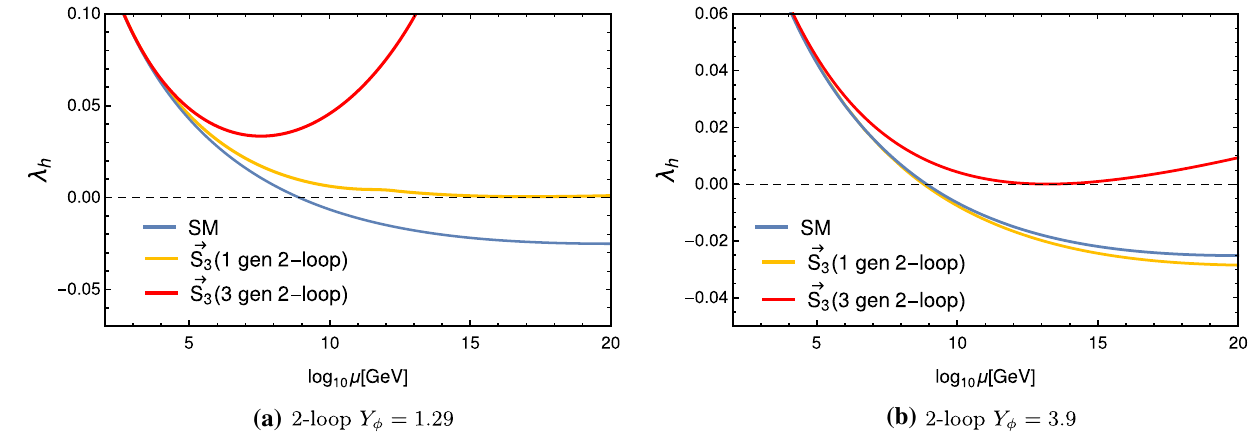
Fig. 10 Running of Higgs quartic coupling with scale for triplet lep- toquark S 3 at two-loop level. Here, λ h running for SM, one gener- ation and three generations of S 3 is delineated by blue, yellow and red curves, respectively. If Y φ is assumed to be greater than 1.29, the